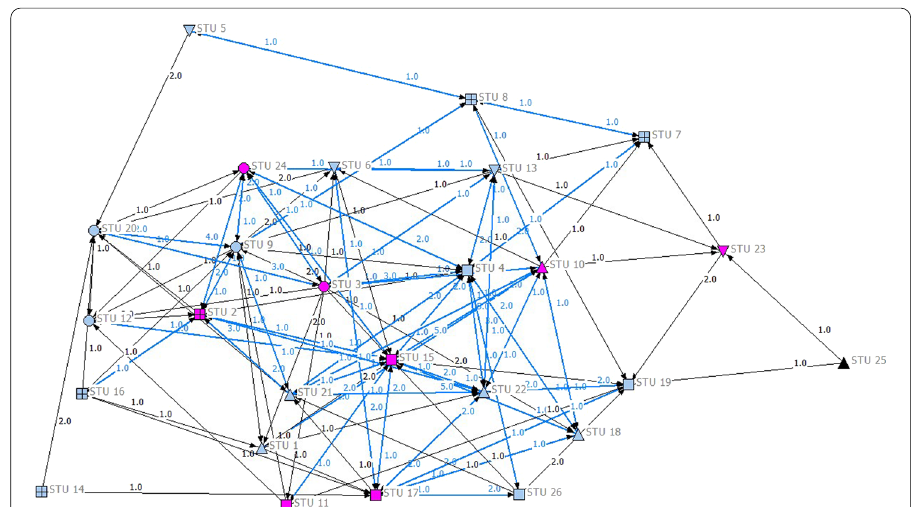
Fig. 7 Social network interaction pattern for the GAFCC group (including original posts and peer comments). Notes: The pink nodes indicate students with final scores from 85 to 100 (A grade); the blue nodes indicate students with final scores from 75 to 84 (B grade); the black nodes indicate students with final scores from 60 to 74 (C grade). Blue ties refer to reciprocal ties, and black ties are non-reciprocal ties. There are five study groups in this course, all formed by students exercising free choice. A circle (open circle) indicates Group 1; a square (open square) indicates Group 2; an upwards pointing triangle (open triangle) indicates Group 3; a box (open box) indicates Group 4; and a downward-pointing triangle (open downward triangle) indicates Group